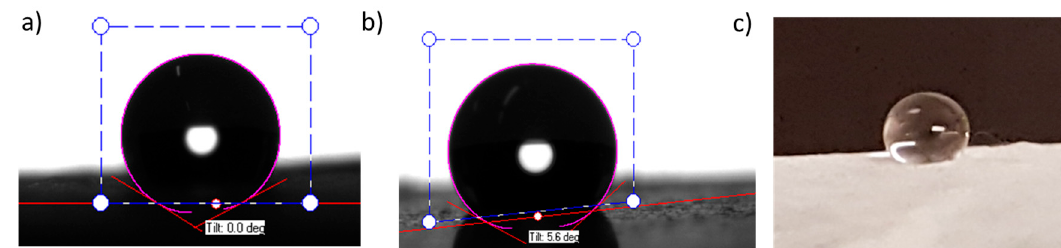
Figure 10. Optical images of the water contact angle values on the polyvinyl chloride (PVC) sample with a value of 151.73° ( a ); PVC-ZnO samples with a value of 146.39° ( b ); aspect of the water drop deposited onto a surface coated with the electrospun fibres. Reprinted with permission of [72]. Metals 2020 , 10 , x FOR PEER REVIEW